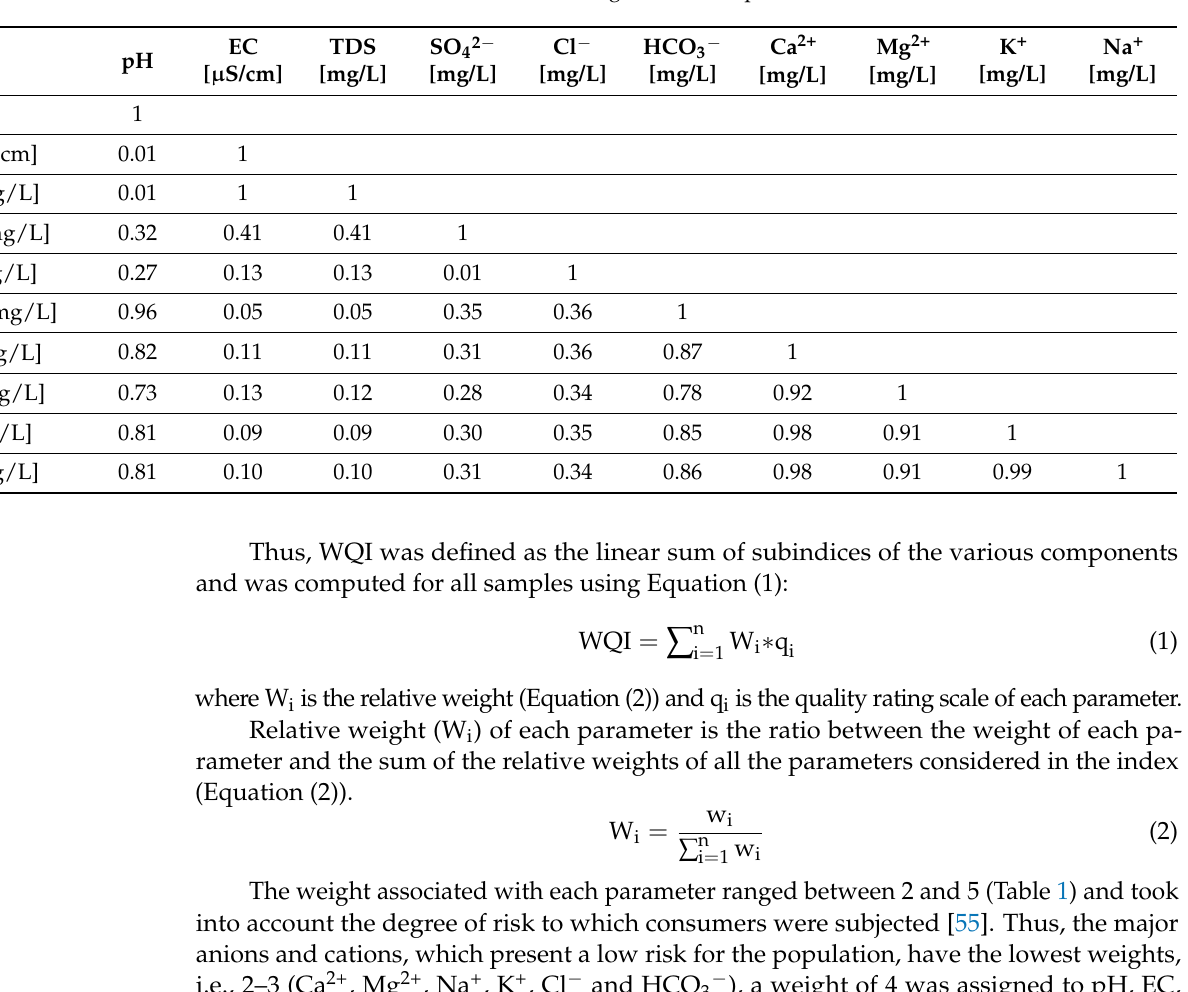
Table 1. Coefficients of determination for groundwater